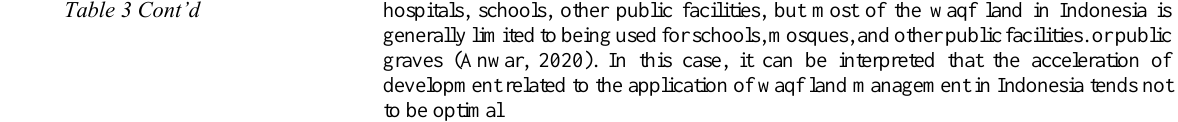
hospitals, schools, other public facilities, but most of the waqf land in Indonesia is generally limited to being used for schools, mosques, and other public facilities. or public graves (Anwar, 2020). In this case, it can be interpreted that the acceleration of development related to the application of waqf land management in Indonesia tends not to be